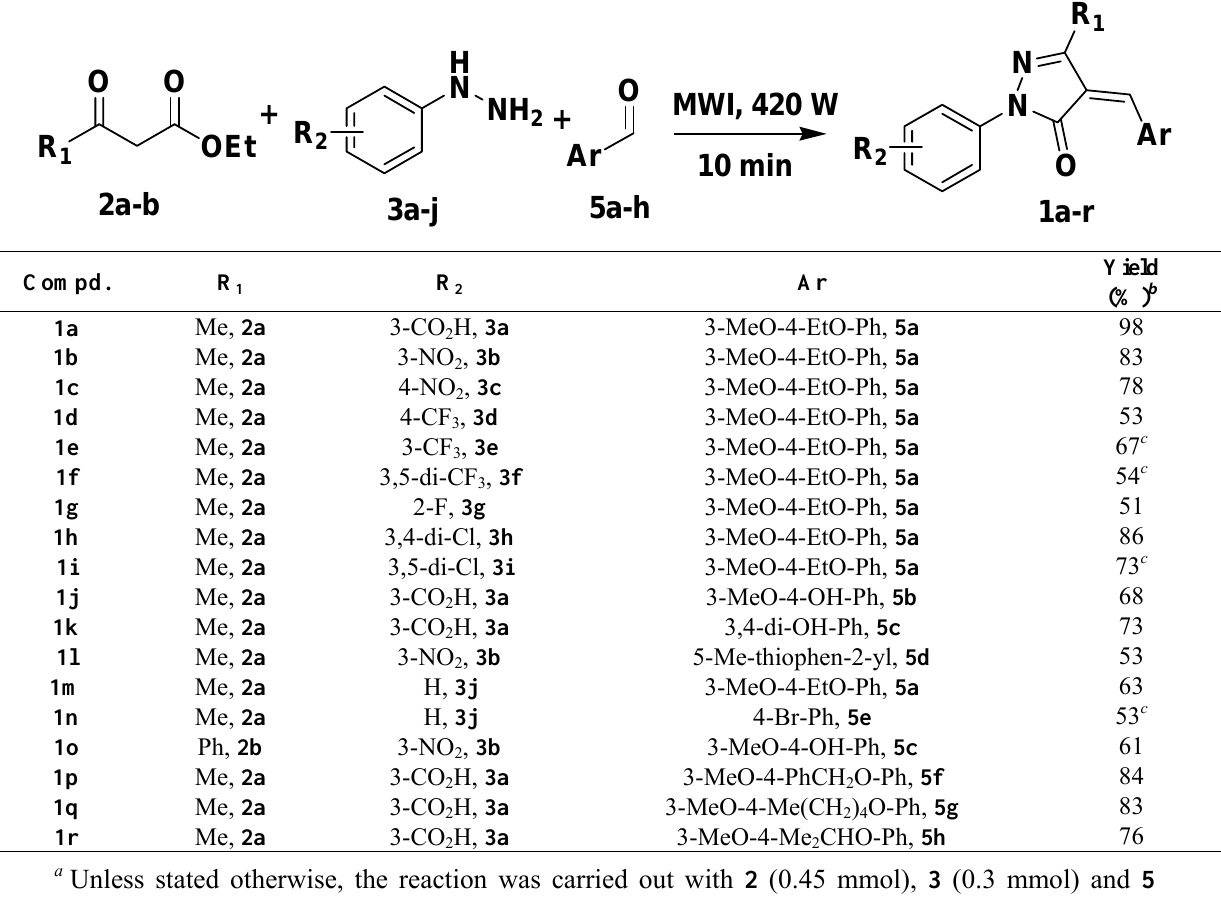
Table 3. Scope of microwave-assisted one-pot synthesis of 4-arylidenepyrazolone derivatives.